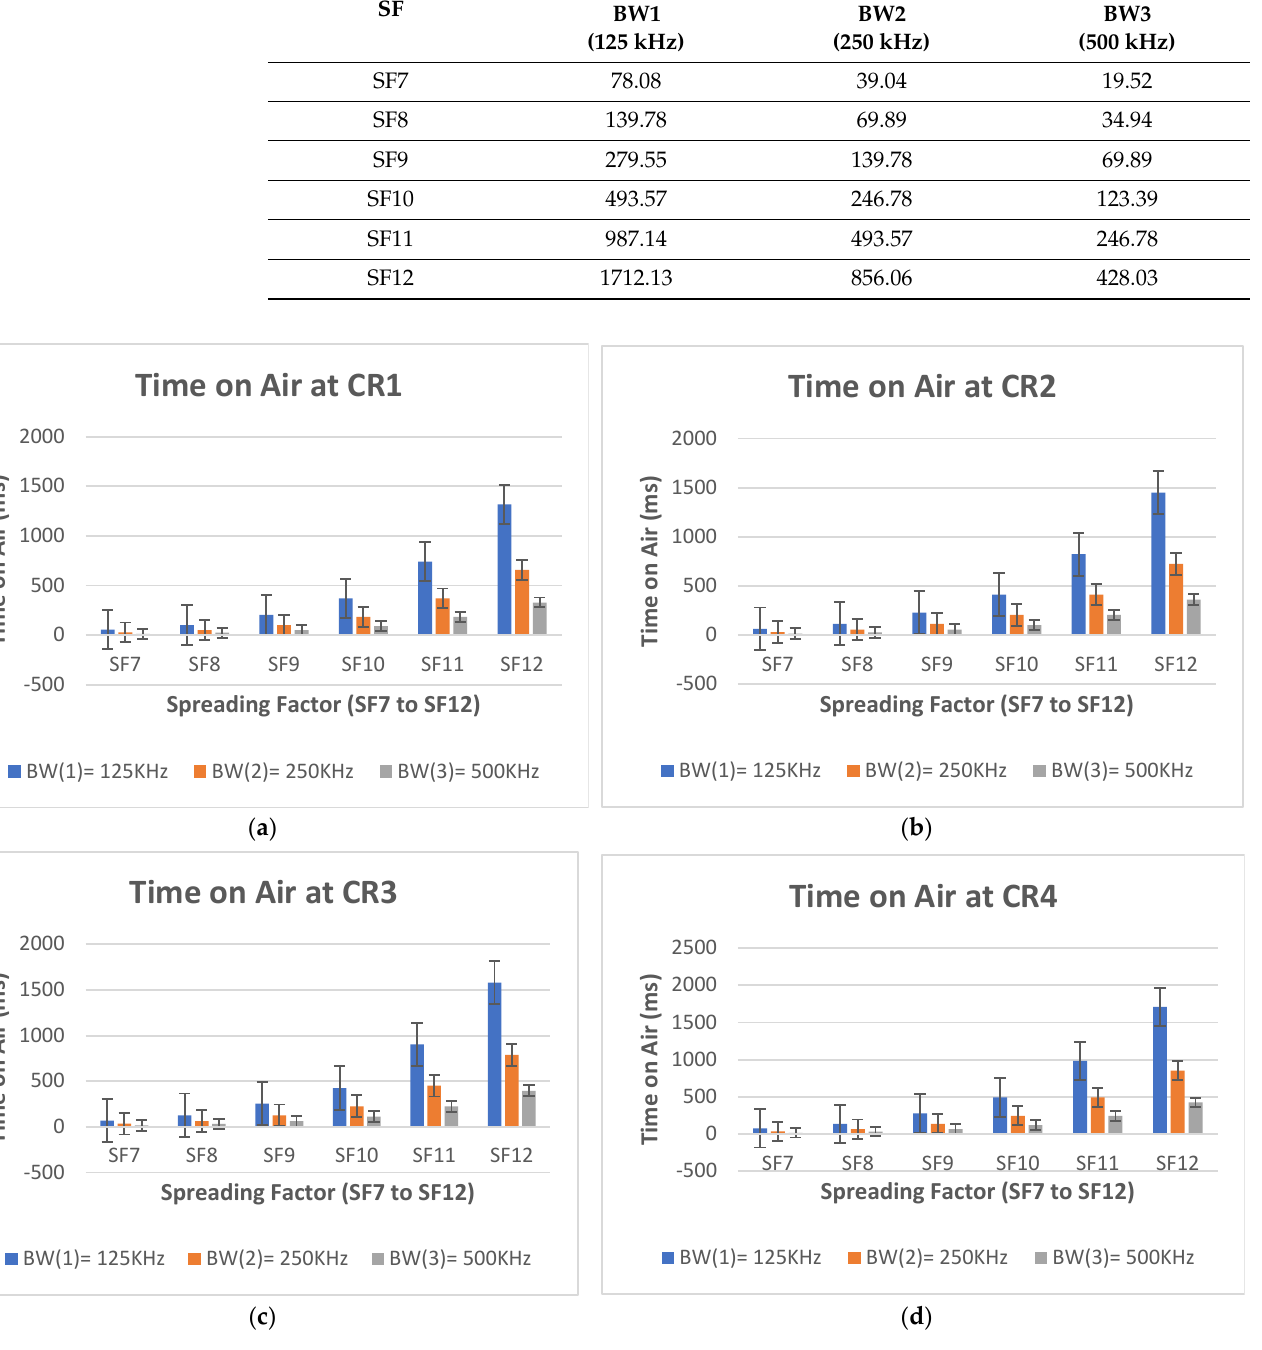
Figure 13. Time on air for a payload length of 25 bytes and preamble length of 8 symbols. ( a ) Time on air at CR1. ( b ) Time on air at CR2. ( c ) Time on air at CR3. ( d ) Time on air at CR4.